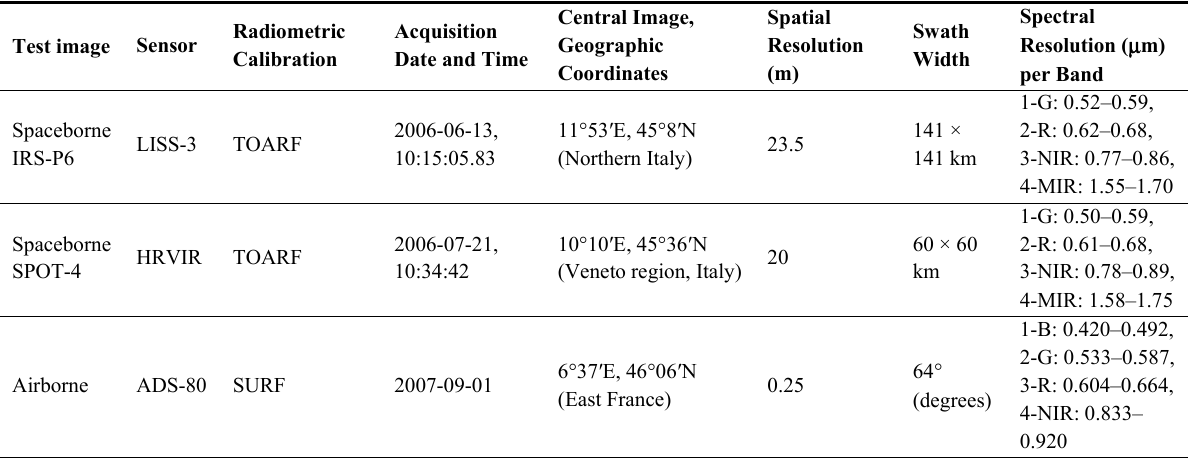
Table 1. Test data set. Acronyms: top-of-atmosphere (TOA) reflectance (TOARF), surface reflectance